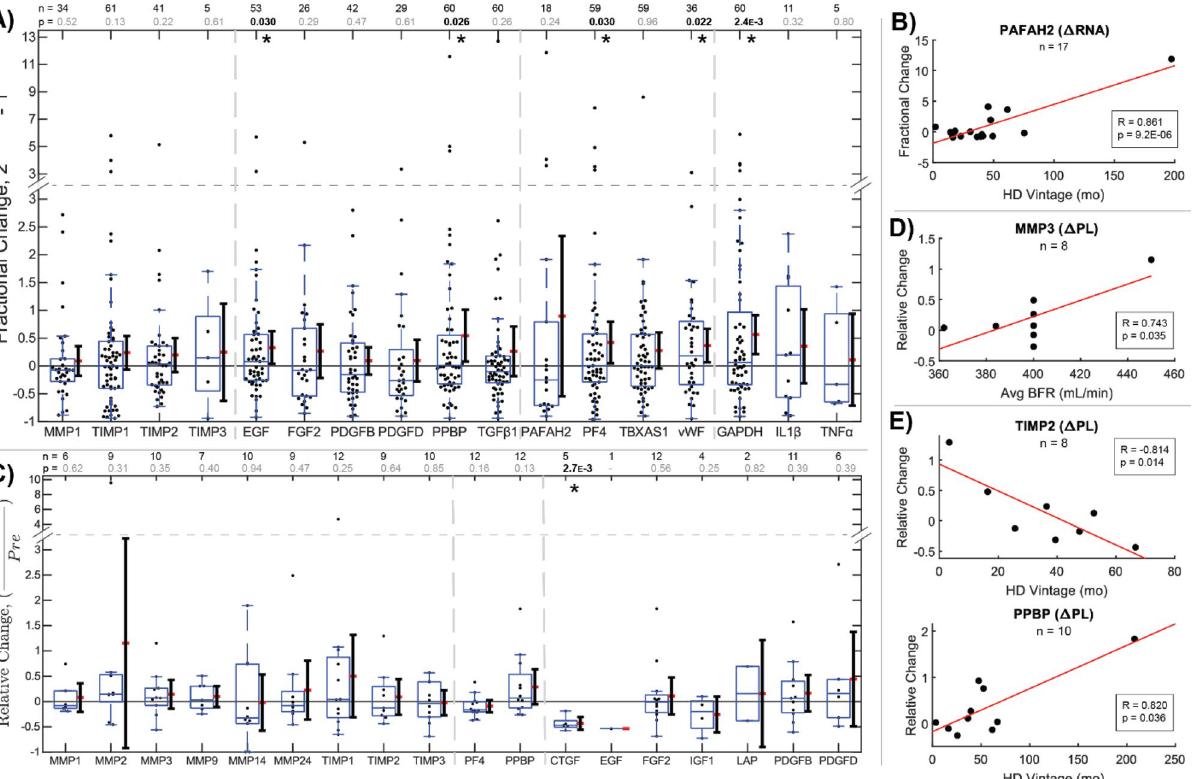
Figure 3. Intra-dialysis platelet transcriptome and secretome changes reflect long-term drivers of dysfunction. ( A ) Relative changes in paired platelet lysate RNA composition in dialysis patients pre- and post-treatment as measured by qPCR. Disproportionate increases in transcripts post-dialysis show selective upregulation of TIMPs and MMP1 degradation in a majority of patients. Fibro-protective EGF, pro-fibrotic PPBP, clotting factors PF4 and vWF, and GAPDH significantly increased by t test, reflecting changes affecting a diverse set of mechanisms. * p < 0.05. Box and whisker plots represent quartiles. Adjacent ranges represent mean (red) ± 95% confidence interval. ( B ) A significant Pearson correlation ( p < 0.05) shows increasing capacity for PAF production with Vintage. ( C ) Relative changes in paired platelet lysate protein composition in pre- and post-treatment as measured by Western Blot. Statistical significance was assessed by one-sample t test. * p < 0.05. ( D and E ) Significant Pearson correlations ( p < 0.05) between intra-dialysis platelet lysate secretome changes and BFR or Vintage, respectively. The positive relationship between MMP3 and BFR supports acute proteolytic enhancement in platelets, while reduction in MMP1 and TIMP2 with Vintage supports sensitization of MMP and TIMP secretion. The positive relationship between PPBP and Vintage reflects the impact of progressive platelet dysfunction on tissue dysregulation. Figure was prepared in Matlab R2019 (Mathworks, Nattick MA, www. mathw orks.